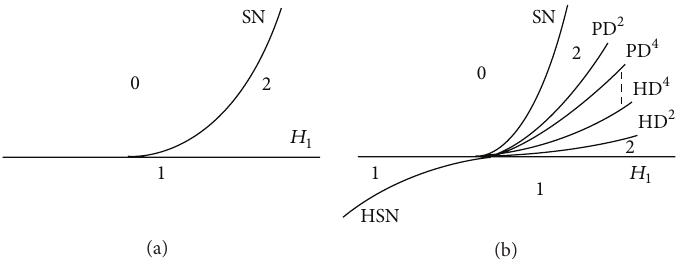
Figure 2: Bifurcation surfaces for 1 + 𝛼 > 𝛽 , ] > 𝛽 in (a) and for 1 + 𝛼 > 𝛽 > ] in (b). 0 means no periodic orbits and 𝑛 means 𝑛 periodic orbits. Chaos occurs in the region bounded by HD 2